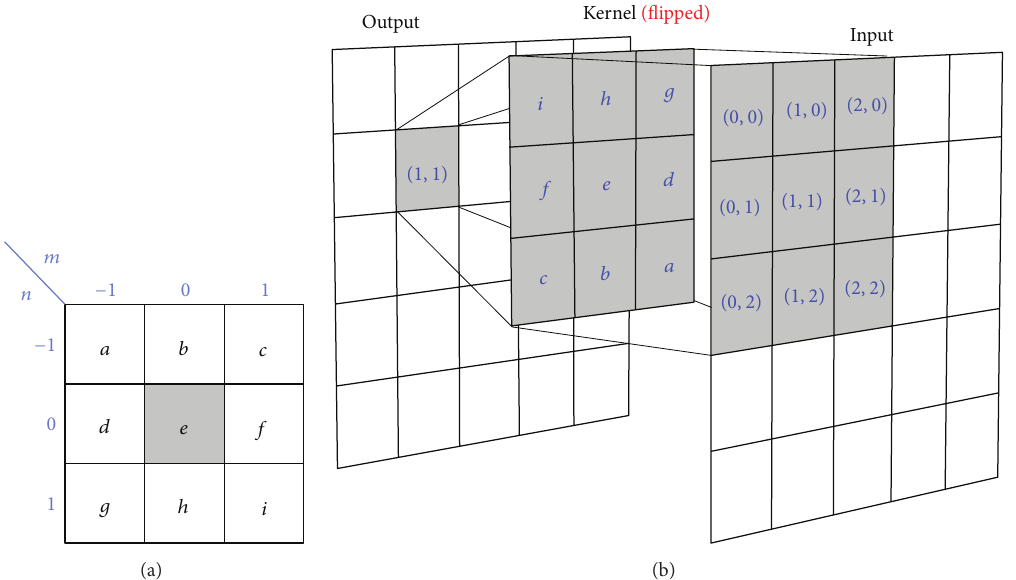
Figure 2: Convolution architecture concept. (a) 3 × 3 filter kernel. (b) Convolution operation (see equations (8) and